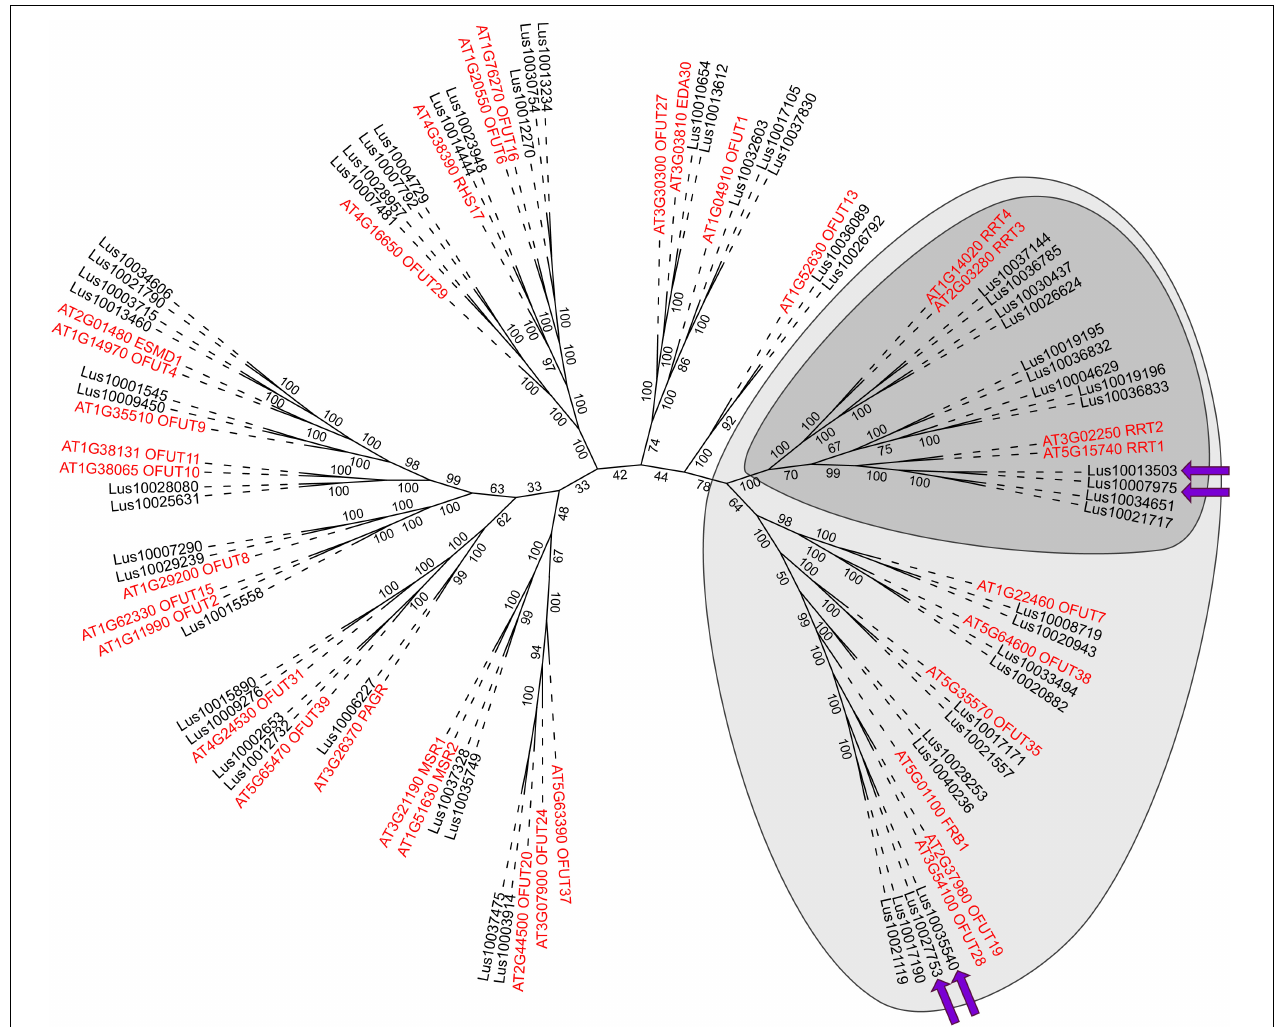
FIGURE 4 | Maximum-likelihood phylogenetic dendrogram of plant GT106 protein family members (with PF10250 and IPR024709 domains) of flax (black) and Arabidopsis thaliana (red). Dark gray confines the RG-I:rhamnosyltransferase (RRT) clade, according to Takenaka et al. (2018), and light gray indicates the RRT clade size, according to Wachananawat et al. (2020). Purple arrows show genes upregulated in the pulling side xylem during gravitropic response. The A. thaliana gene names are according to the annotation of the Uniprot database 8 (Bateman et al., 2019). Numbers indicate the ultrafast bootstrap support values; branch lengths were